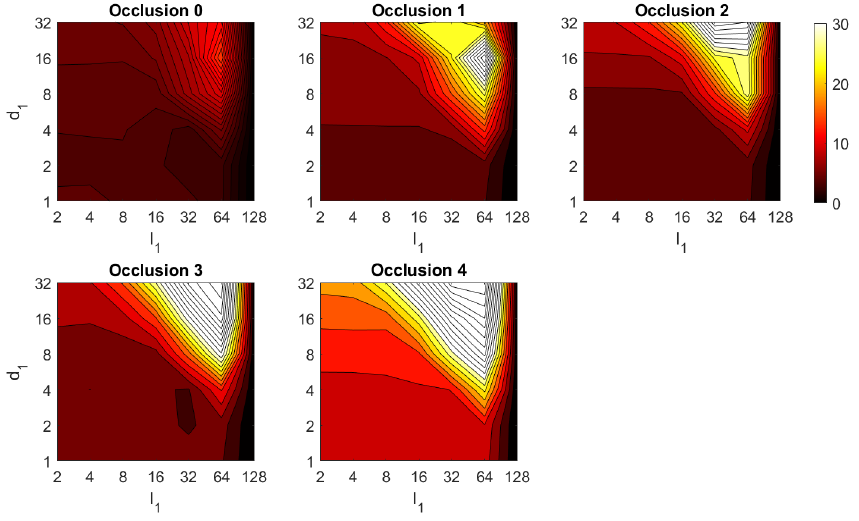
Figure 34. HOG orientation estimation in the presence of occlusion. Average orientation error